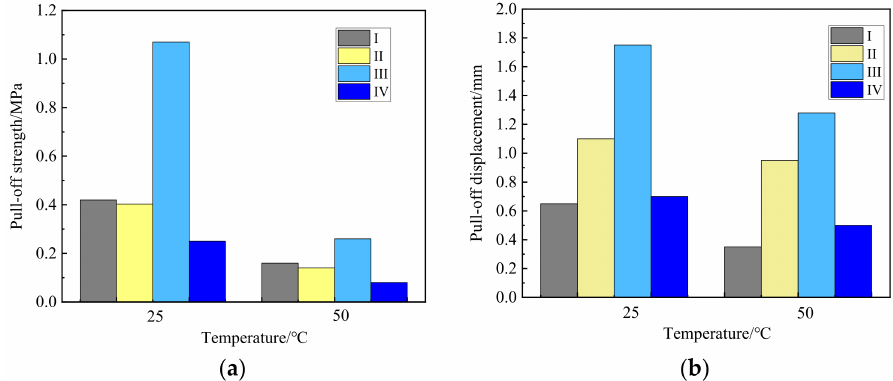
Figure 11. Test results of pull-off test. ( a ) Pull-off strength. ( b ) Pull-off displacement.